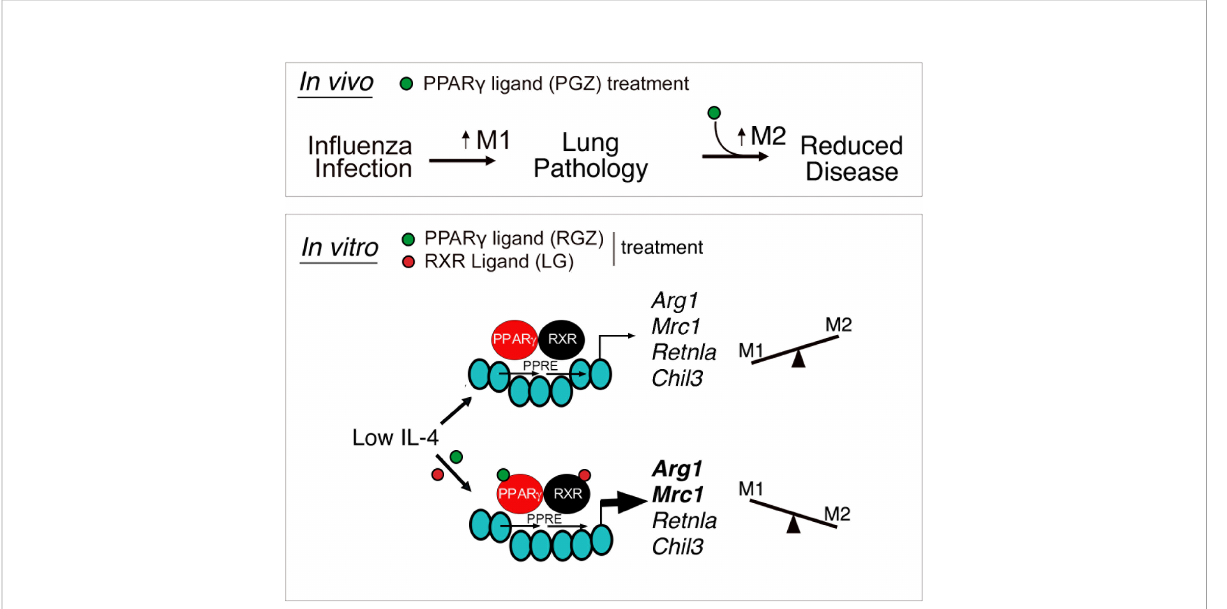
GRAPHICAL ABSTRACT Upper panel: In vivo model depicting regulation of lung-induced pathology by M1 and M2 macrophages. In absence or in the presence of low levels of in fl uenza-induced IL-4, treatment with PPAR g agonist, Pioglitazone (PGZ), enhances M2 macrophage polarization and reduces in fl uenza-induced lung disease. Lower panel: In vitro IL-4-dependent regulation of canonical M2a macrophages genes is selectively modulated by ligands speci fi c for PPAR g /RXR heterodimers. PPAR g /RXR heterodimers gain access to a peroxisome proliferator activated receptor response element (PPRE) in the promoter of canonical M2a macrophage genes, inducing their expression in a ligand-independent manner. However, in the presence of ligands for both PPAR g and RXR [Rosiglitazone (RGZ) and LG100764 (LG), respectively], liganded heterodimers selectively enhance the expression of some M2a genes ( Arg1 and Mrc1 ) without affecting the others ( Retnla and Chil3